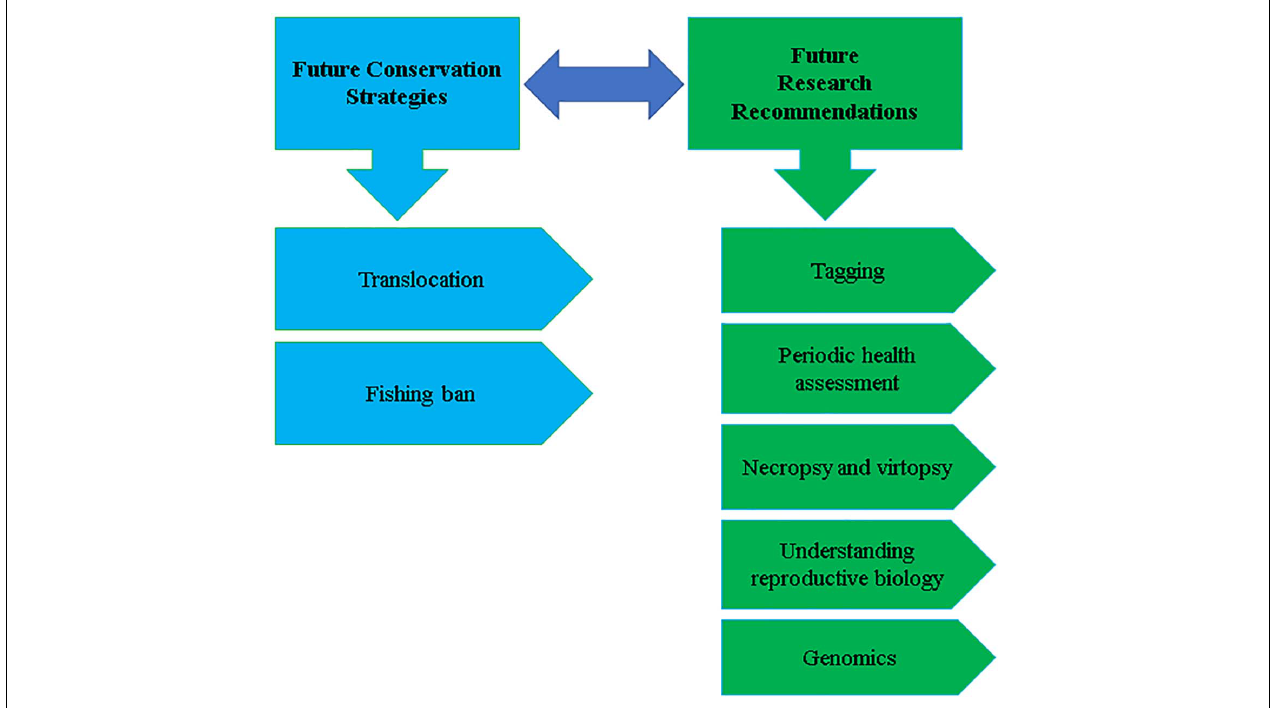
FIGURE 3 | Summary of the strategies for future conservation of Indus River